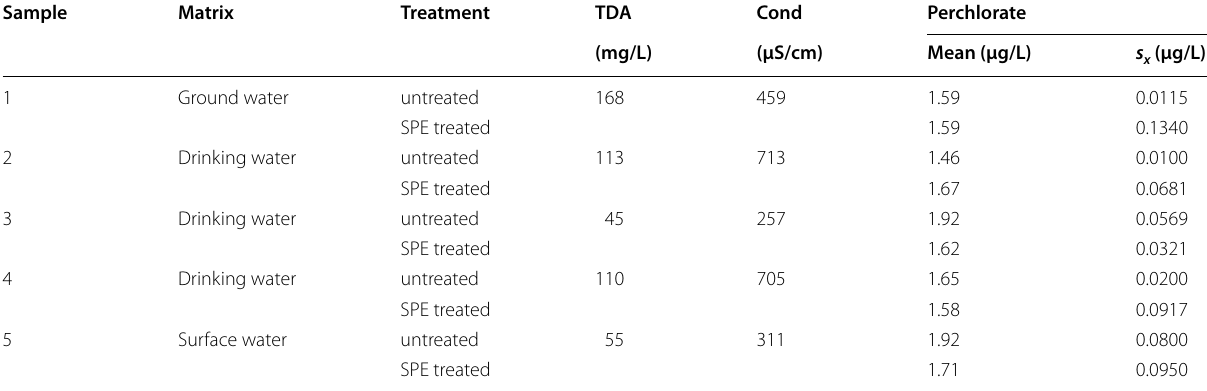
TDA, Total dissolved anions; Cond, Conductivity; s x , repeatability standard deviation